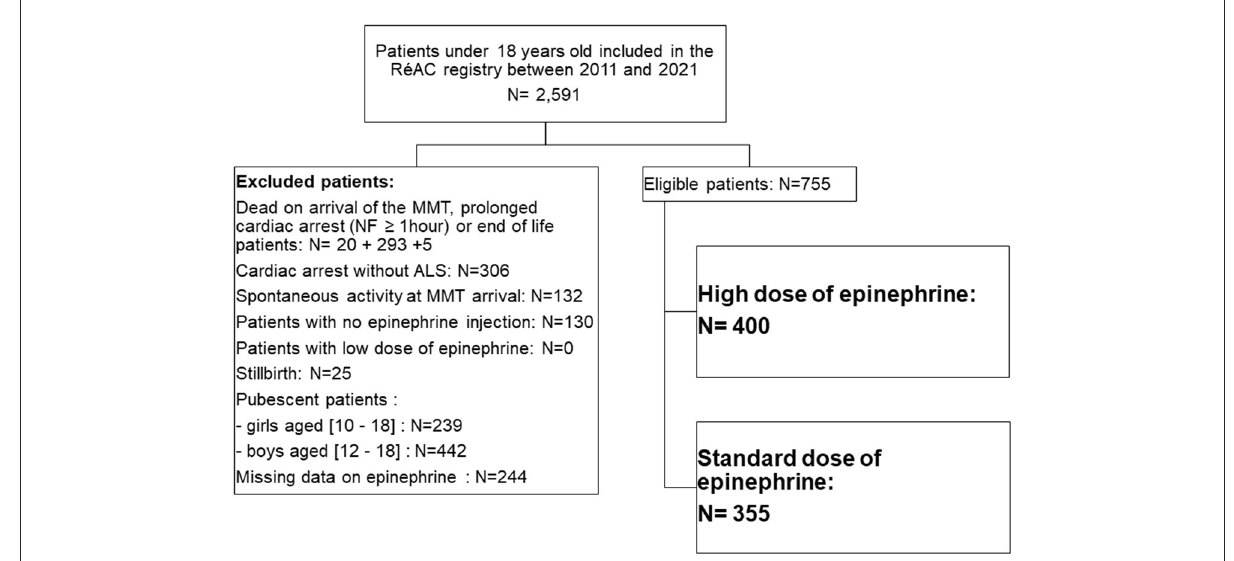
FIGURE1 Flow chart of study cohort. ALS, advanced life support; MMT, mobile medical team; NF, no-flow.